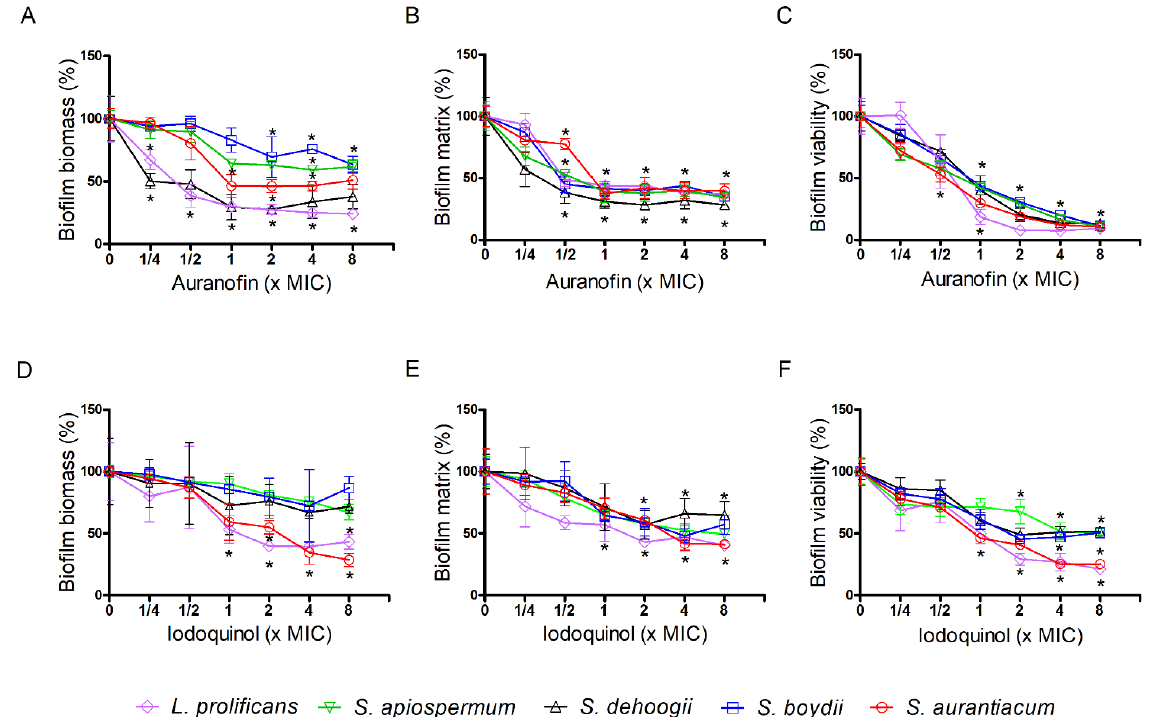
Figure 3. Effect of auranofin ( A – C ) and iodoquinol ( D – F ) on preformed biofilms of Scedosporium and Lomentospora species. Fungal biofilm was firstly formed in RPMI 1640 medium for 24 h and then it was treated with different concentrations of auranofin or iodoquinol for another 24 h incubation. Fungal biomass ( A , D ), extracellular matrix ( B , E ) and viability ( C , F ) were measured using violet crystal, safranin and XTT-reduction assay, respectively. * p < 0.01, compared to 0 (absence of drug) for each species.